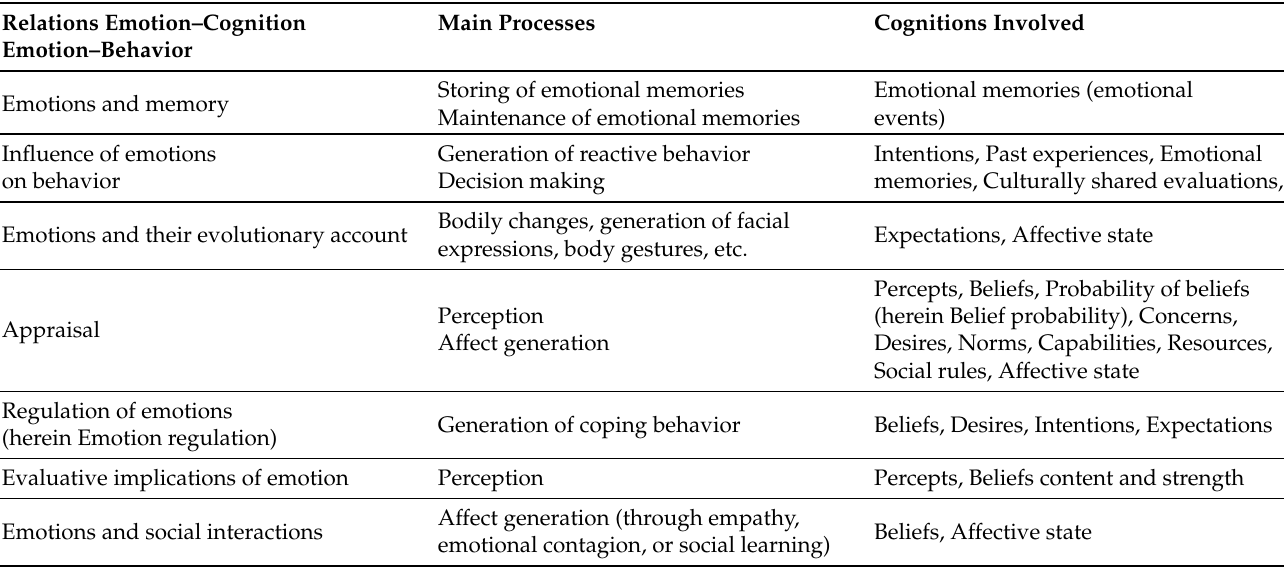
Table 1. The main processes and cognitions of emotion–cognition and emotion–behavior